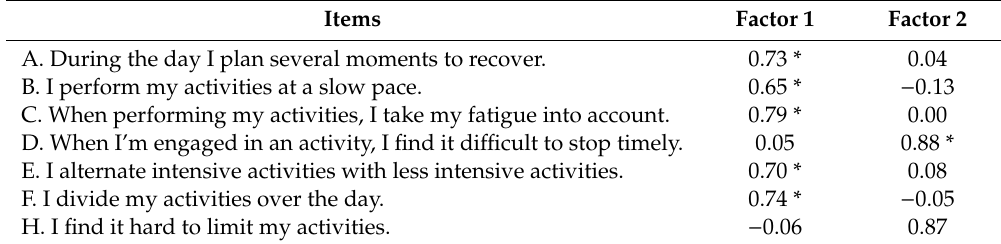
Table A1. Factor loadings of the seven items of the Activity Pacing and Risk of Overactivity Questionnaire using Principal Component Analysis with oblique rotation. Items Factor 1 Factor